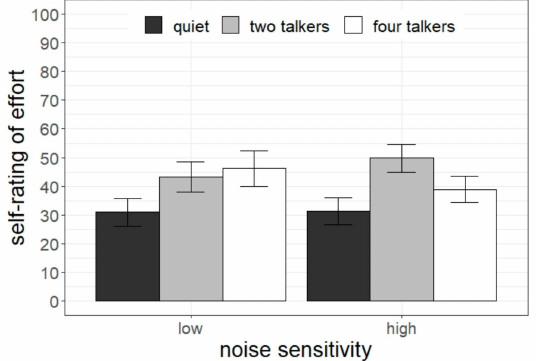
Figure 5. Subjective assessment of listening effort as a function of students’ noise sensitivity and listening condition. Error bars indicate standard